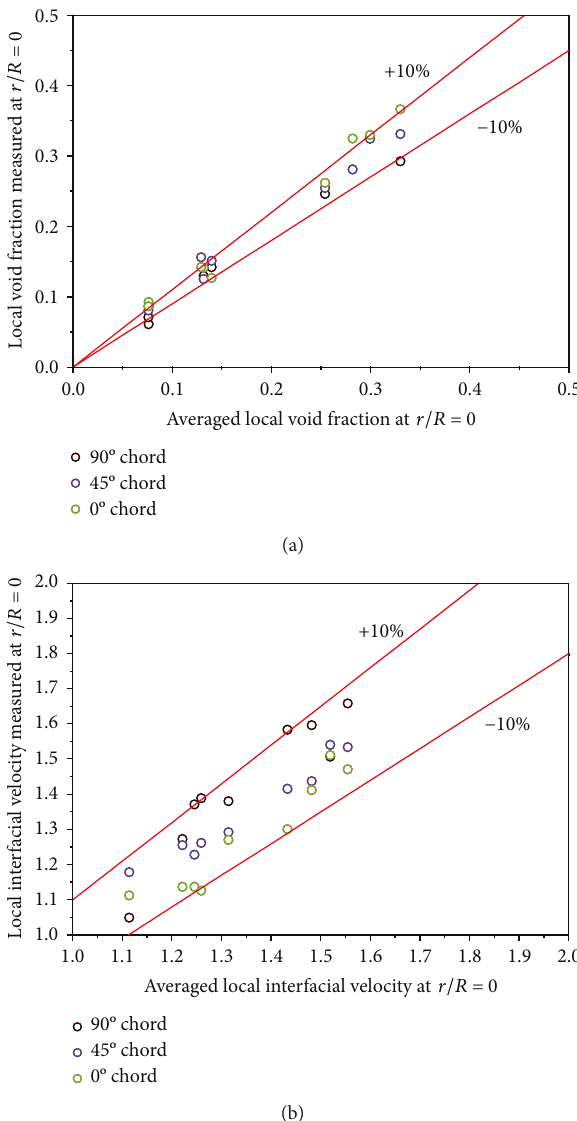
Figure 4: Repeatability of the two-sensor optical probe measurement at r / R =0: (a) void fraction; (b) interfacial velocity.